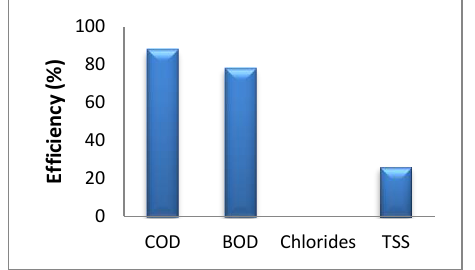
Figure 4: Efficiency of Wastewater Treatment Plant. Physio-chemical parameters i.e., COD, BOD, Chlorides and TSS are